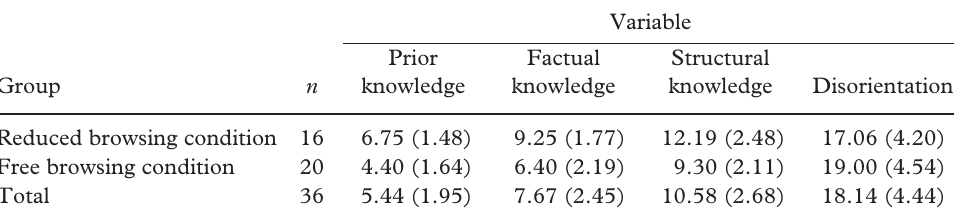
Table 1. Means (standard deviations) of the variables under consideration